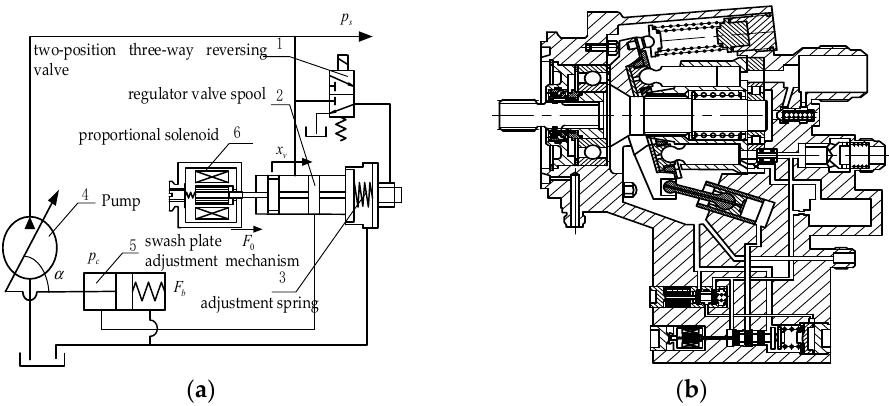
Figure 2. ( a ) Program of a pressure continuous regulation for EHPAAPP; ( b ) Schematic of a pressure continuous regulation for EHPAAPP.